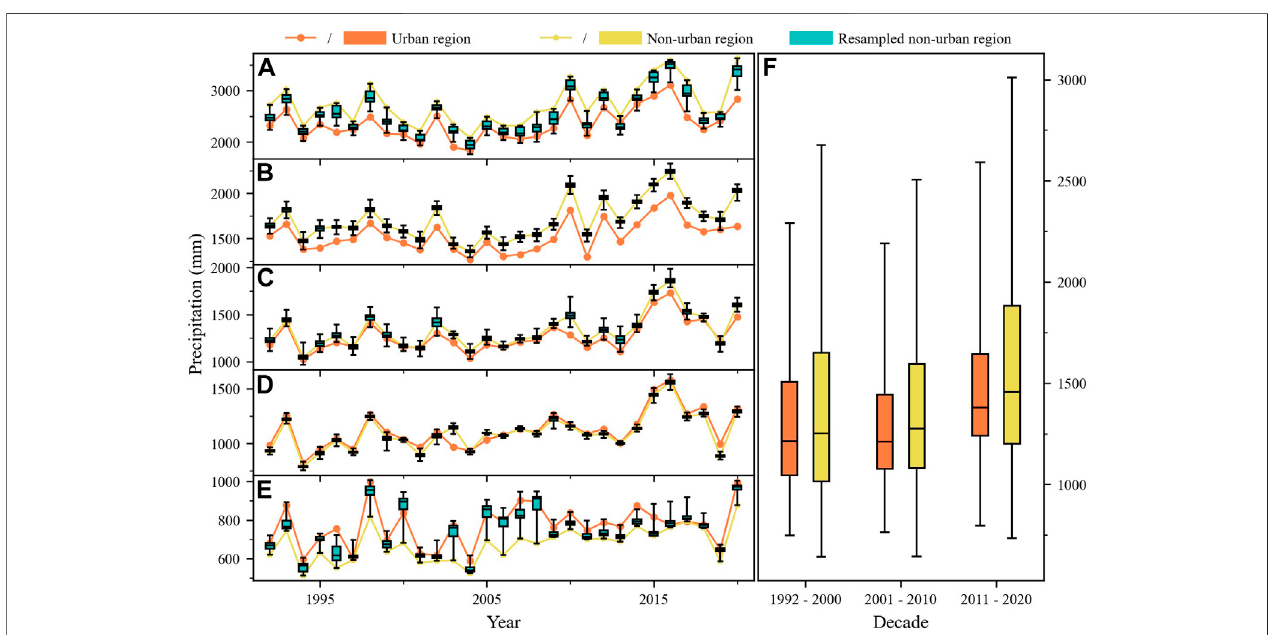
FIGURE 9 | The annual TP from 1992 to 2020 in the YDM. Yearly fl uctuations of (A) maximum, (B) 75th percentile, (C) median, (D) 25th percentile, and (E) minimum. (F) boxplot of decadal averages.